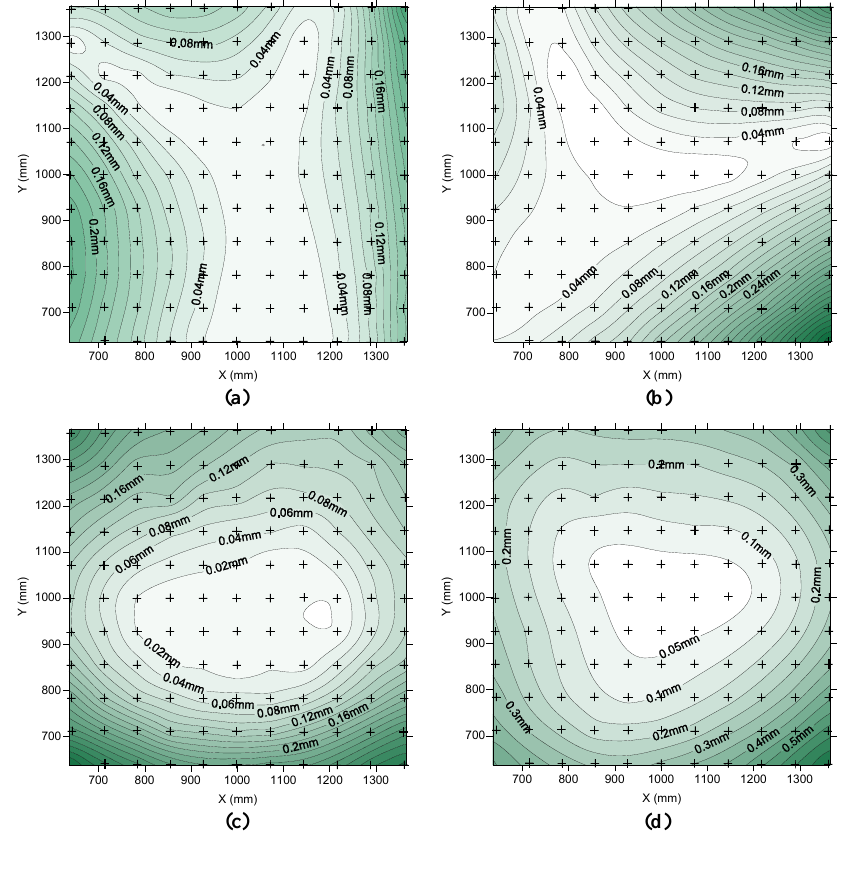
Figure 8. Spatial distribution of differences (mm) between the measurements and the “true” coordinates according to X (a), Y (b), Z (c) and the total vector length